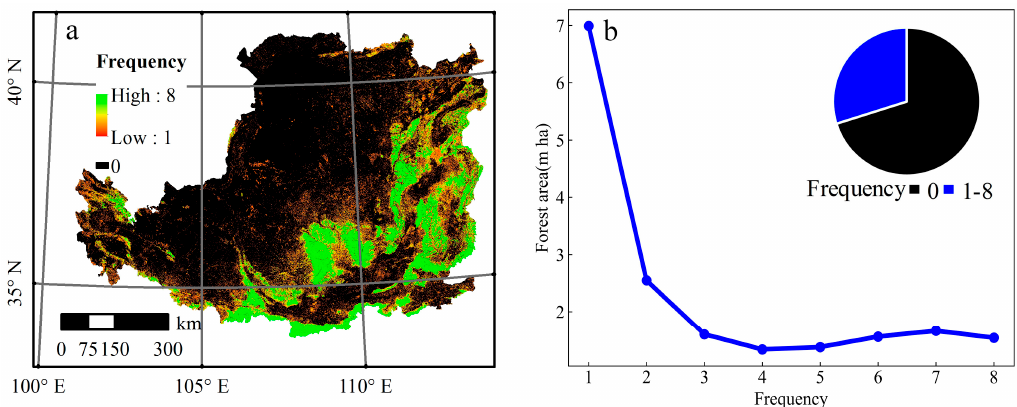
Figure 6. Discrepancy of the eight types of forest products. ( a ) Spatial distribution of forest product discrepancy based on forest frequency; ( b ) frequency distribution of forest counts.